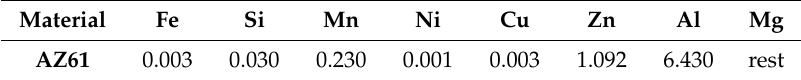
Table 1. The chemical composition of the AZ61 magnesium alloy (in wt.%).